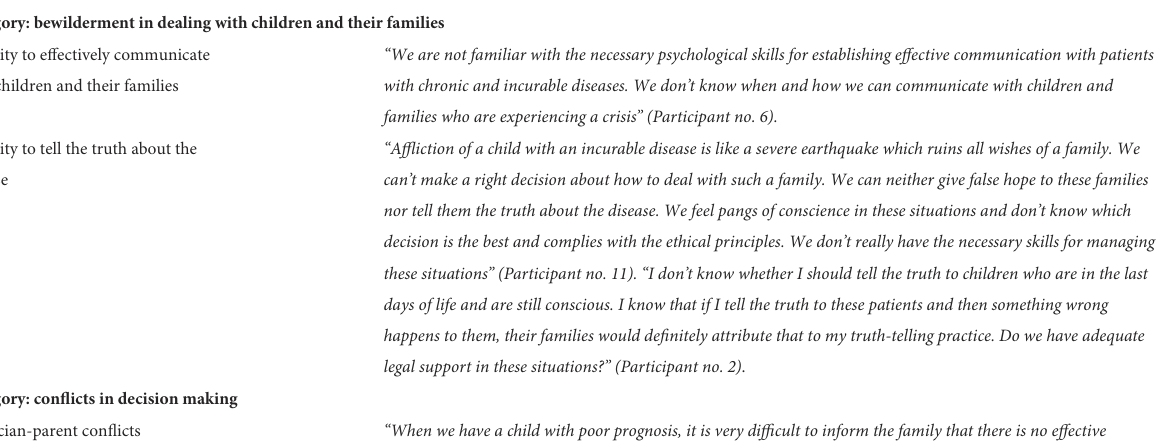
TABLE 4 Categories, subcategories, and examples of quotations.